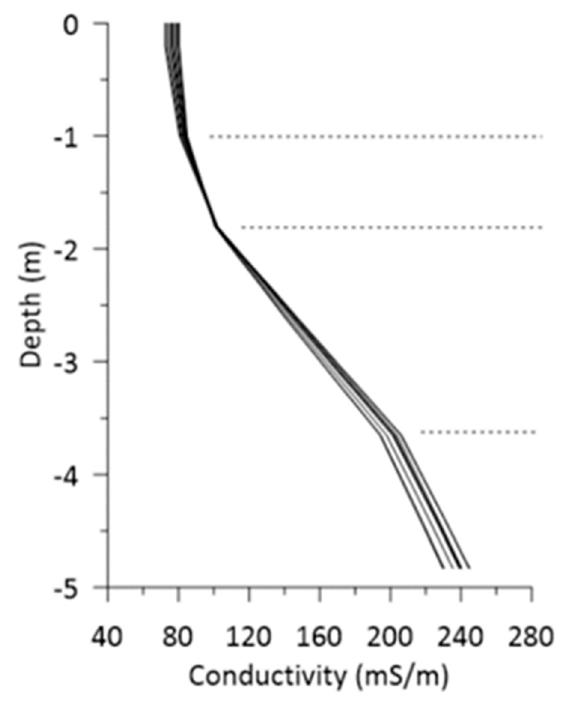
Figure 5. Electrical conductivity profile around the coring site (within +/ − 2.5 m surface distance along with profile TST06.